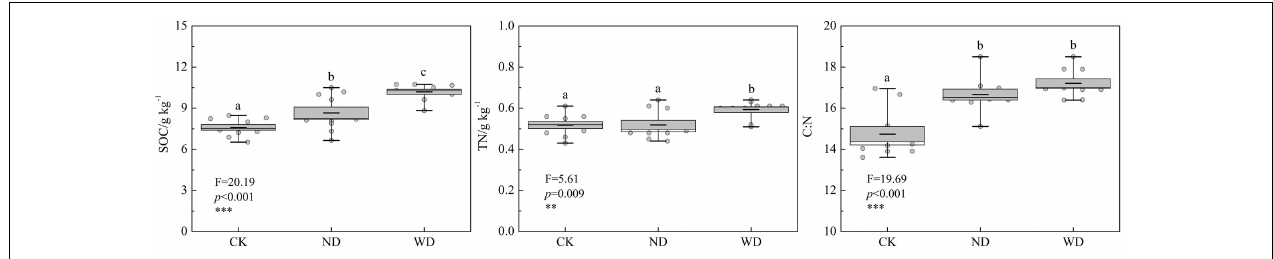
FIGURE 7 | Influence of straw turnover (with and without efficient cellulose decomposer) on soil organic carbon (SOC), total nitrogen (TN), and carbon and nitrogen ratio (C:N) in the field decomposition experiment. CK: bare soil without straw; ND: soil under straw net bags without selected decomposing fungi; WD: soil under straw net bags with selected decomposing fungi. Different letters represent significant difference among the treatments at p <